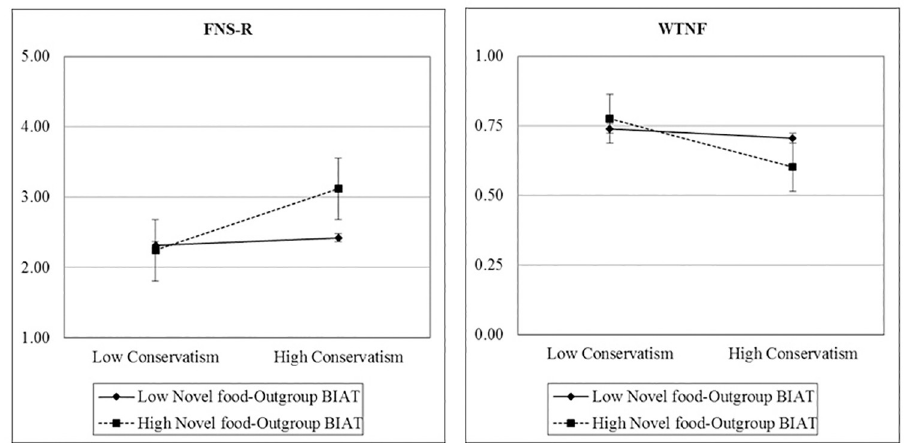
Fig 2. Food neophobia as a function of socio-political ideology moderated by implicit association between novel food and foreigner outgroups (Study 2). Note: Error bars represent standard errors.